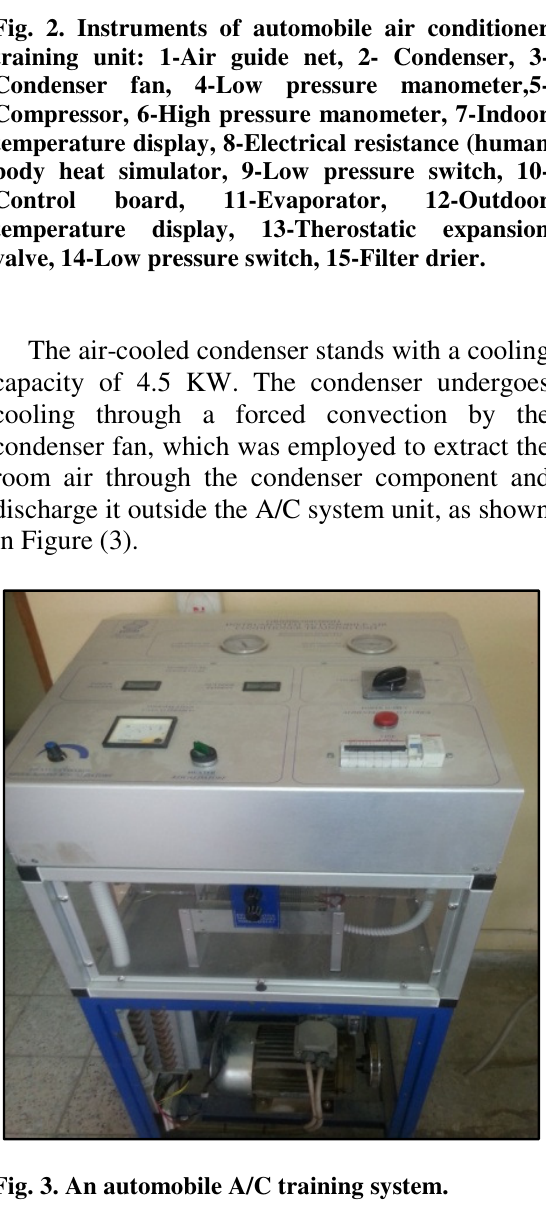
Fig. 3. An automobile A/C training system.